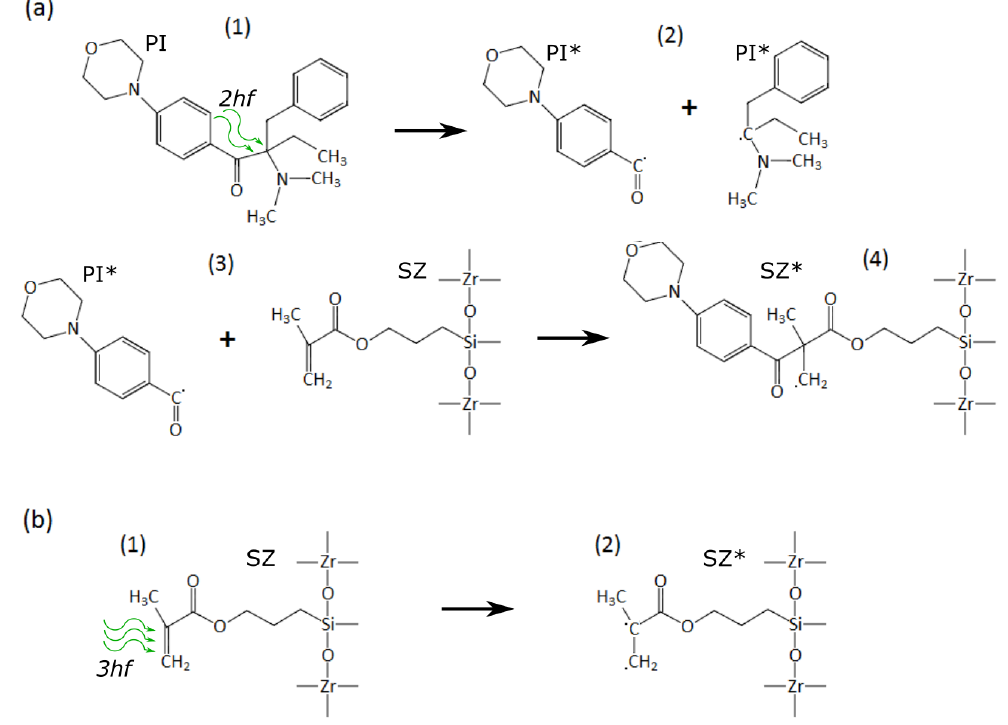
Figure 12. ( a ) polymerization reactions initiated by nonlinear absorption of PI molecules and subsequent chemical pathways resulting in a cross linked SZ2080; ( b ) SZ2080 cross linking without PI. hf is the photon